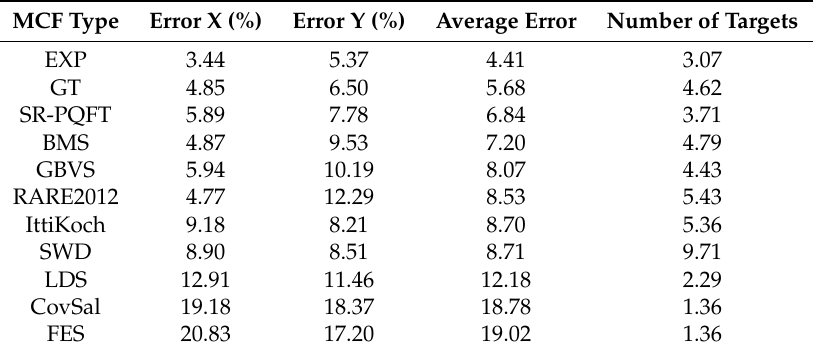
Table 8. Average errors for various saliency models taking MCF DIR and removalPercent = 20.